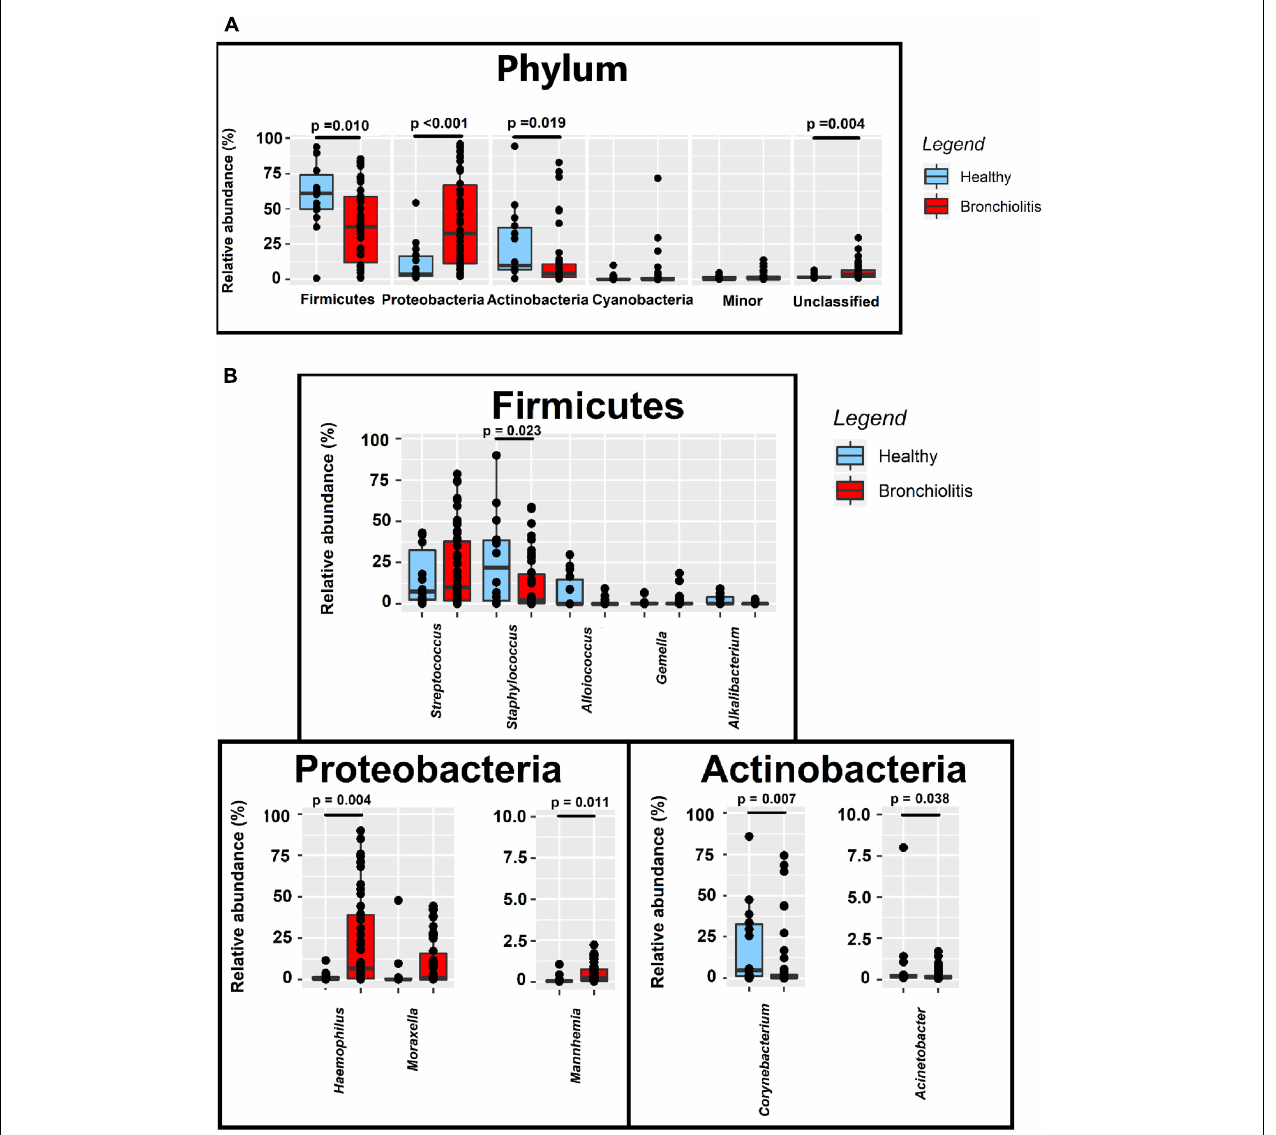
FIGURE 4 | Relative abundance sequences at the phylum (A) and genus (B) level in nasal samples from healthy ( n = 14; blue boxes) and bronchiolitis ( n = 54; red boxes) infants. Significant differences between samples from both groups of infants are indicated (Wilcoxon rank sum